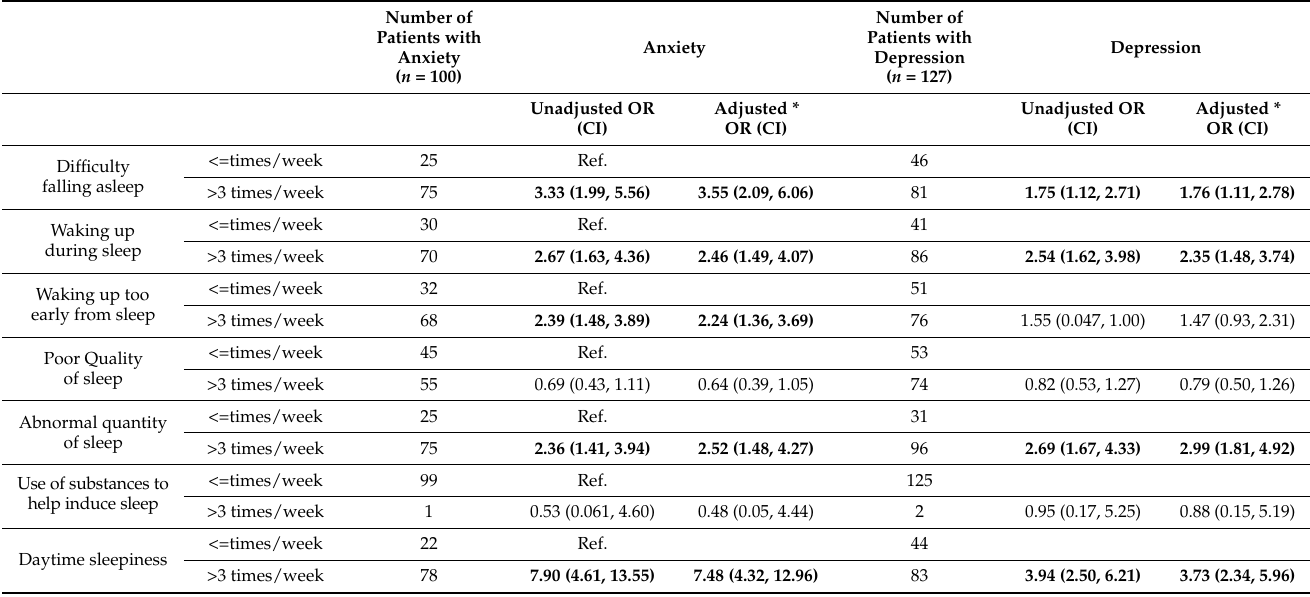
Table 5. Results of logistic regression models that estimated the risk of having anxiety and depression in relation to sleep disturbance